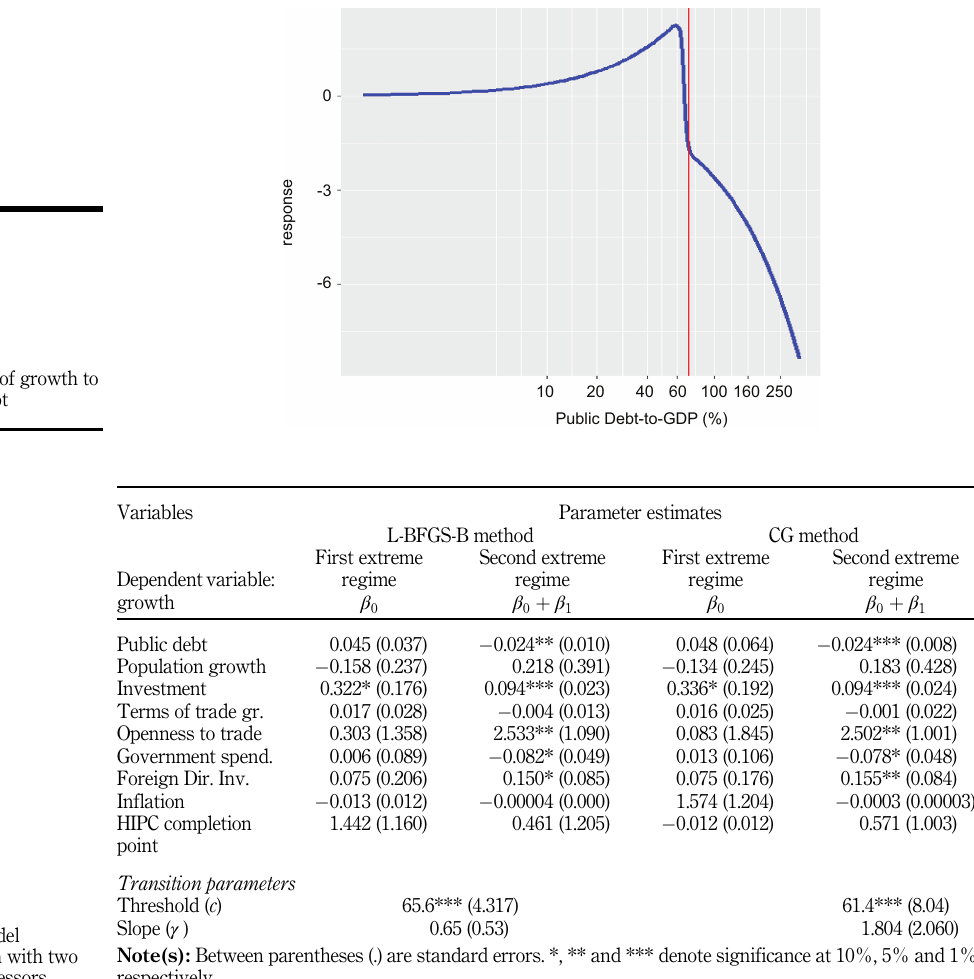
estimation with two more